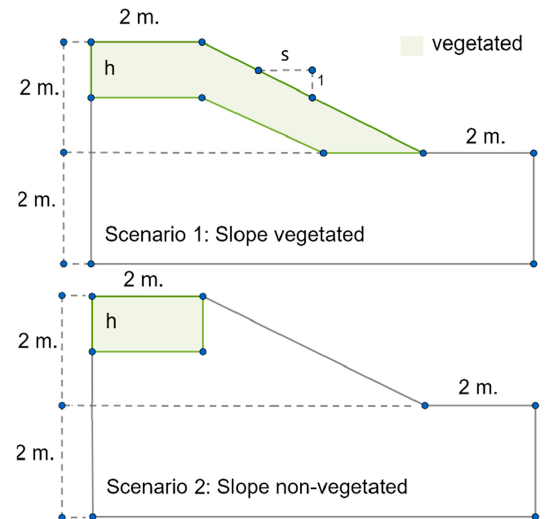
Figure 3. Geometry of the bank slope used in slope stability analysis, where h refers to the depth of the soil with high root density and s is the slope (drawing not to scale).